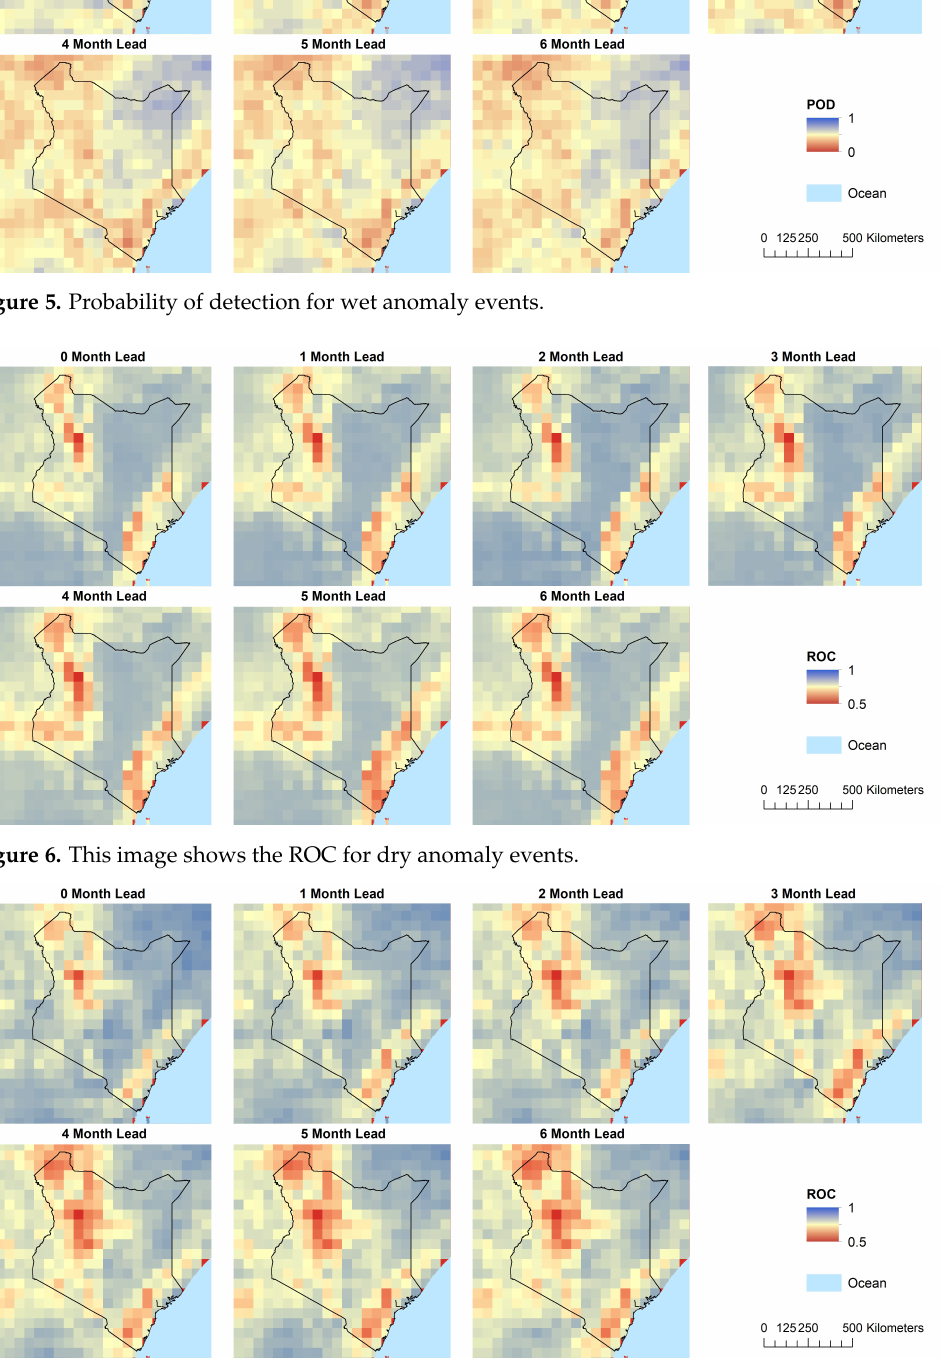
Figure 7. This image shows the ROC for wet anomaly